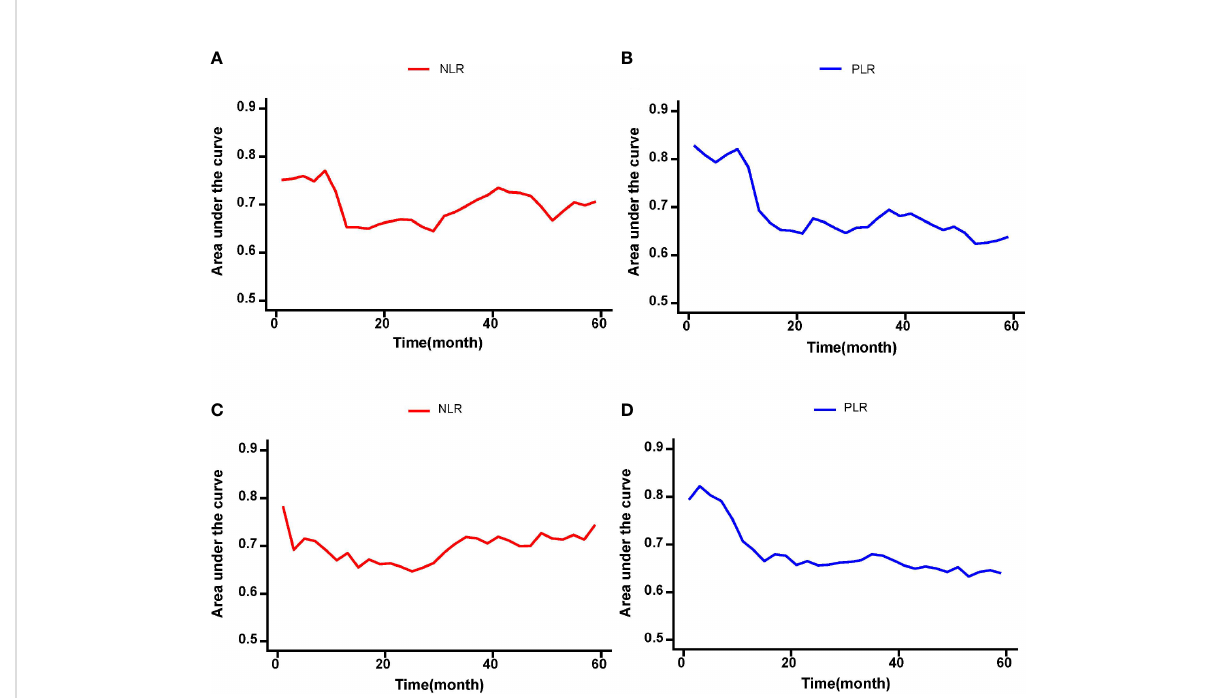
FIGURE 4 The time-dependent ROC curves of the NLR and PLR for OS and RFS in pCCA patients. (A-D) NLR and PLR were useful in effectively predicting long-term outcomes such as OS and RFS according to the results of time-dependent ROC